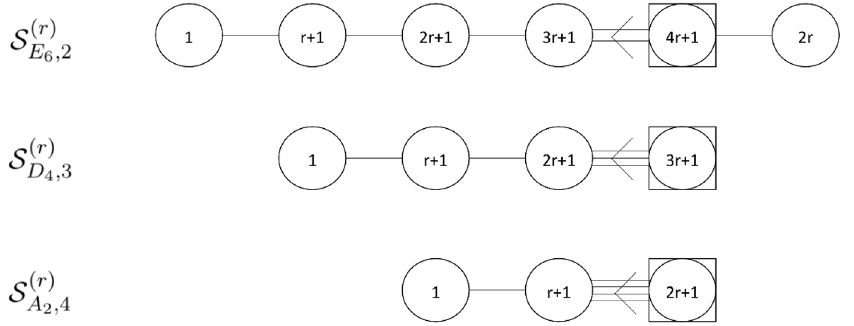
Figure 7. The magnetic quivers for some of the S -theories. Here the square surrounding one of the nodes represents the node where the ungauging is done.